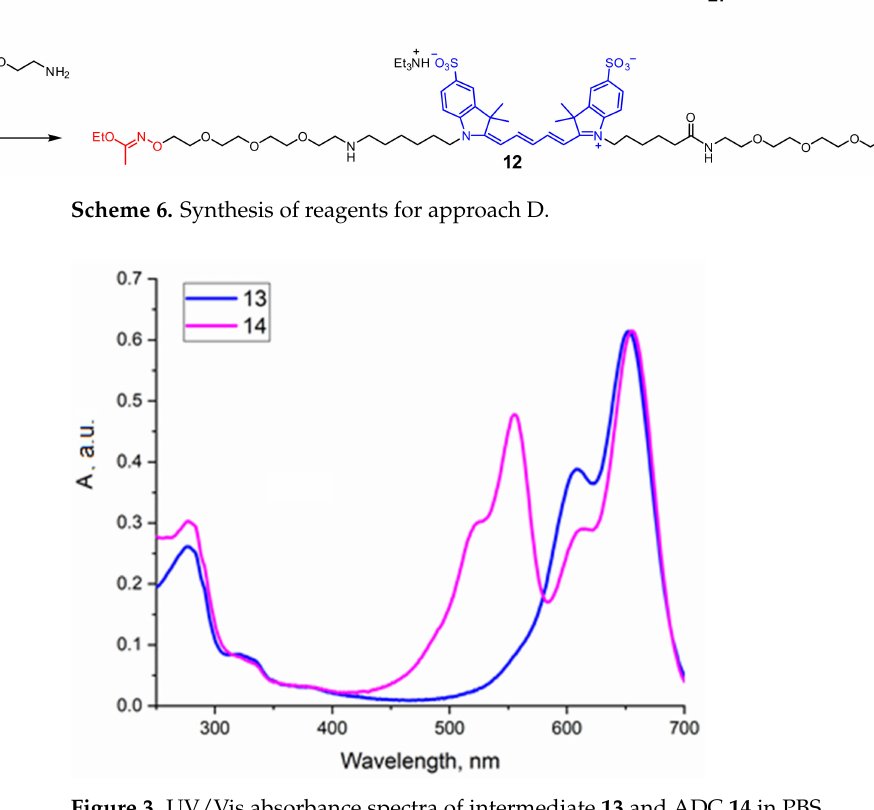
Figure 3. UV/Vis absorbance spectra of intermediate 13 and ADC 14 in PBS.